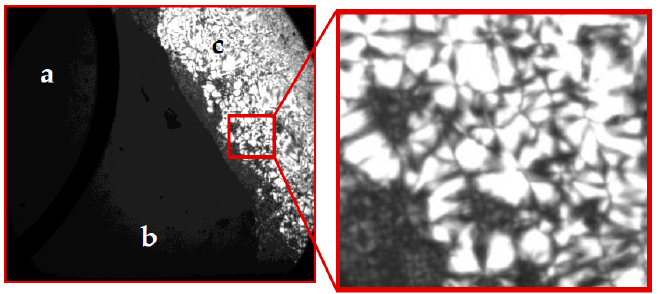
Figure 1. Polarizing micrographs of DGC at 2.5× original magnification: ( a ) air phase; ( b ) isotropic phase; ( c ) anisotropic phase.